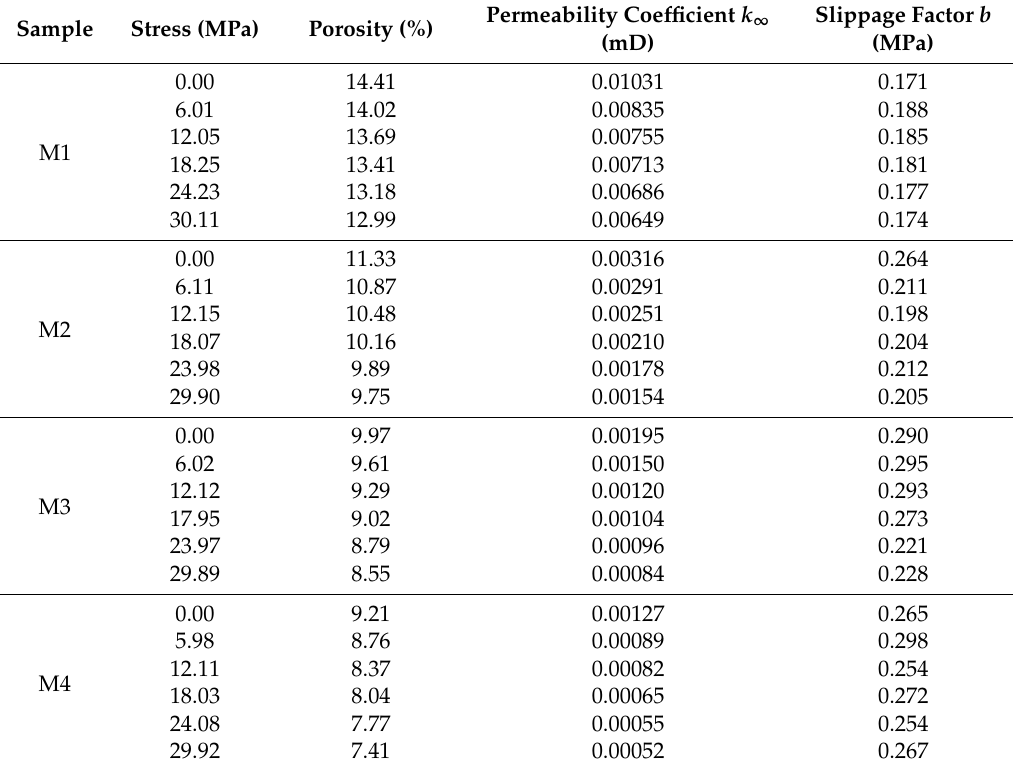
Table 4. The values of the Klinkenberg permeability parameters on coal samples M1–M4 using methane.